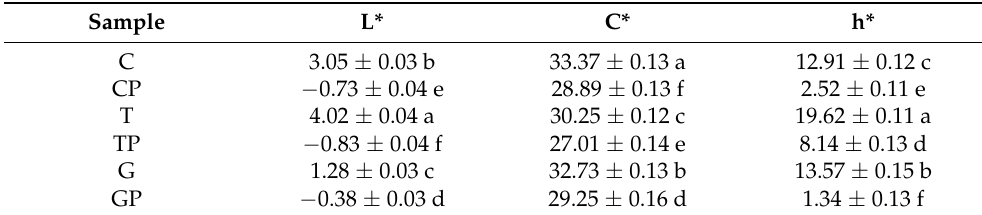
Table 9. Wine CIELAB parameters (L*, C*, h*) at the end of aging.